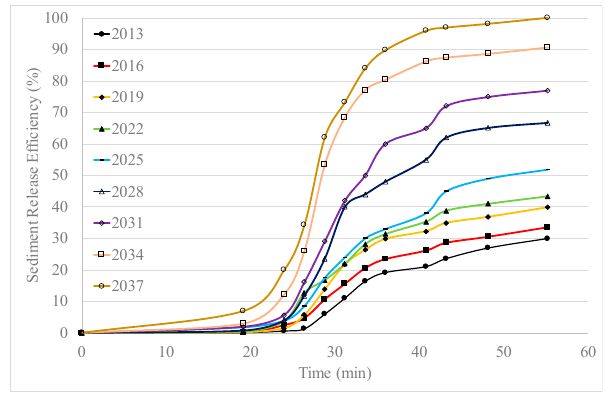
Figure 7. Sediment release efficiency from 2013 to 2037 as computed from measurements in the physical model.